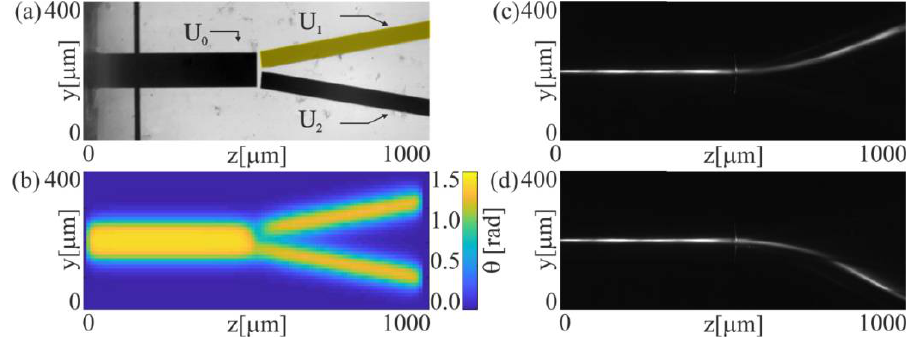
Figure 10. Redirection of nematicon in an optical Y-junction for TM-polarized beam using the phase shift of a driving voltage: ( a ) Electrodes within NLC cell, with a marked one with variable phase. ( b ) Asymmetry in the out-of-plane molecular reorientation when sinusoidal signal U 1 is out of phase with the U 0 and U 2 of the electrical signals—numerical calculations. ( c ) Experimental nonlinear beam propagation of a wavelength λ = 1064 nm and optical power P = 1.5 mW in case of U 1 = 1.7 V remains in phase and ( d ) out of phase to U 0 and U 2 .